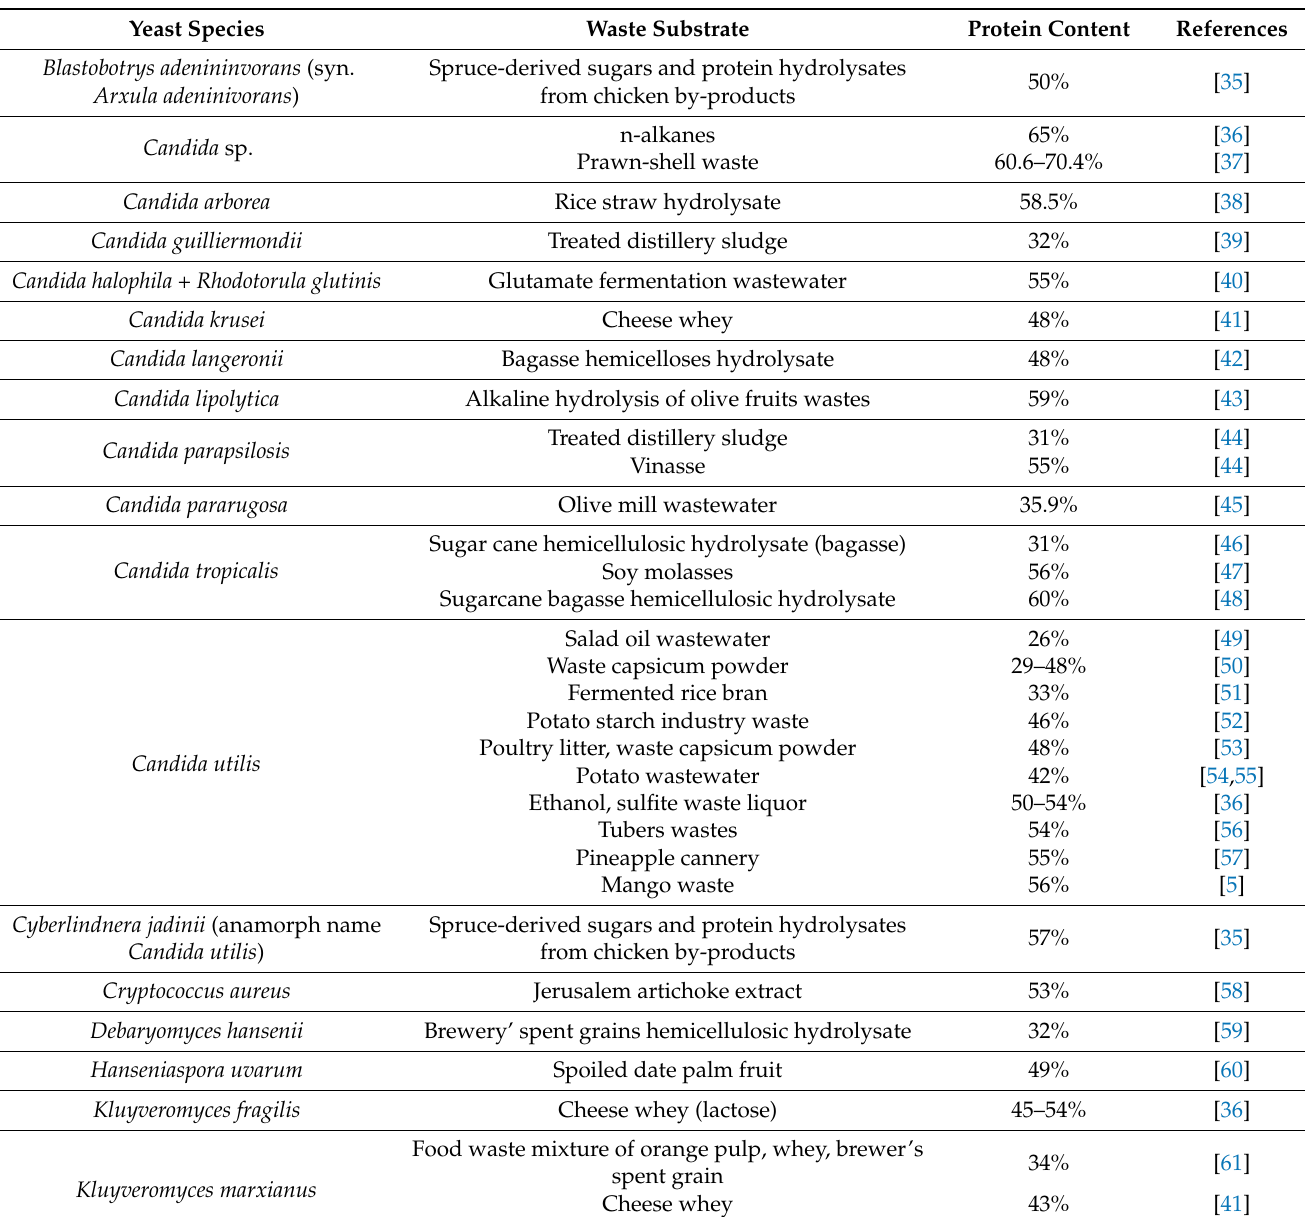
Table 1. Reports of yeast protein content produced from specific waste substrates by different yeast